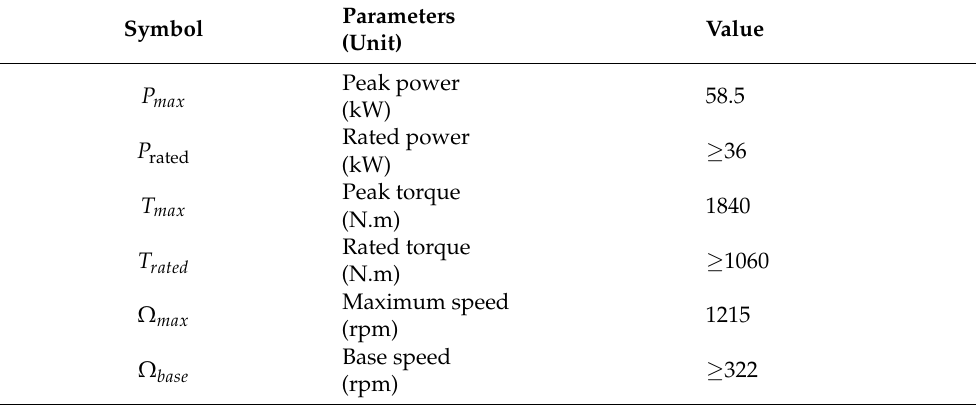
Table 3. Design targets for the direct-drive motor to propel an EV